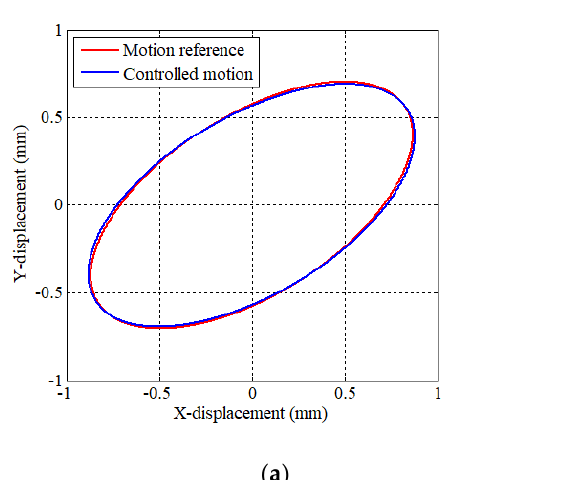
( b ) Figure 12. Displacement estimation of elliptical motion (  : 1mm,  : 0.5mm,  : 35deg.) ( a ) Displacement in the X–Y reference frame and ( b ) displacement in the X  –Y  reference frame.